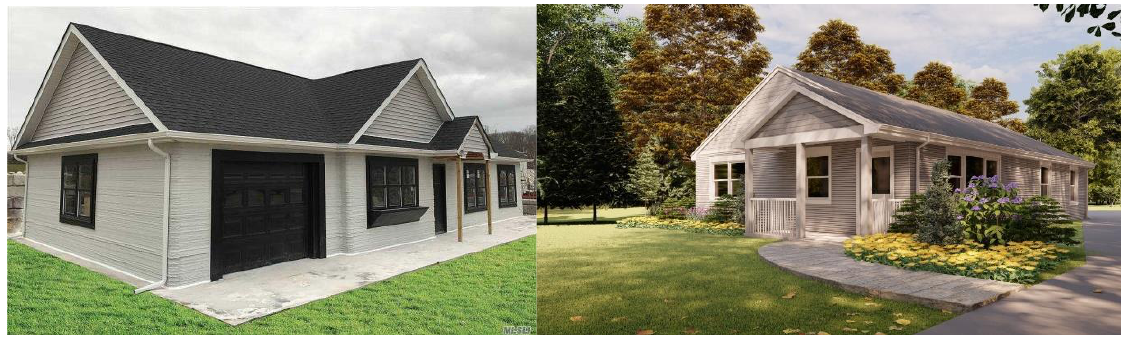
SQ4D INC. Figure 11: Home model prototype (left) and the First Legally Permitted 3D Printed House in the USA for sale online through Zillow